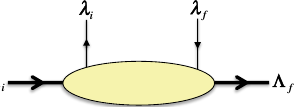
Figure 1: Parton-hadron forward scattering